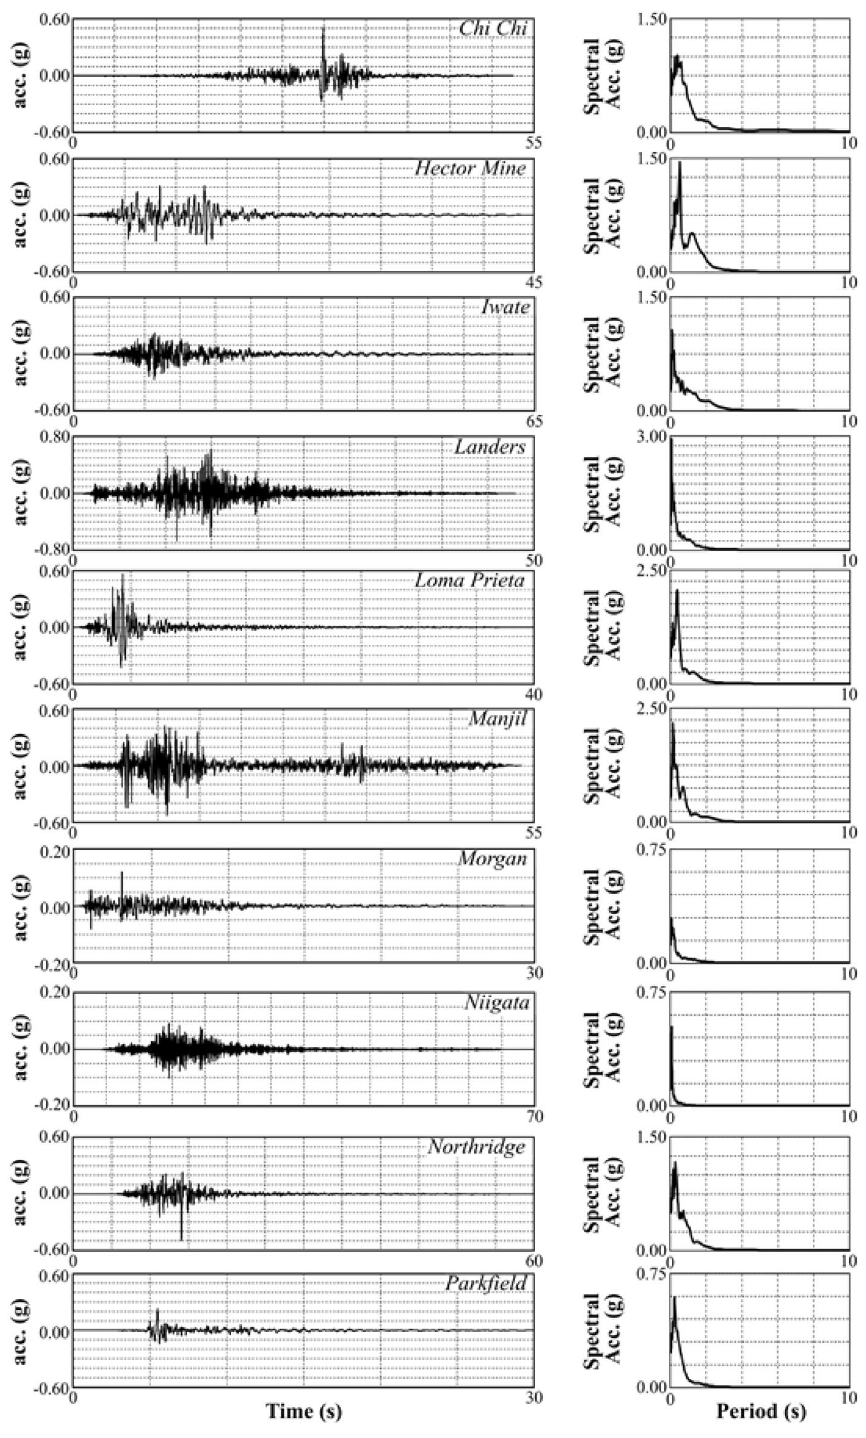
Figure 10. Acceleration-time histories of strong ground motions 99